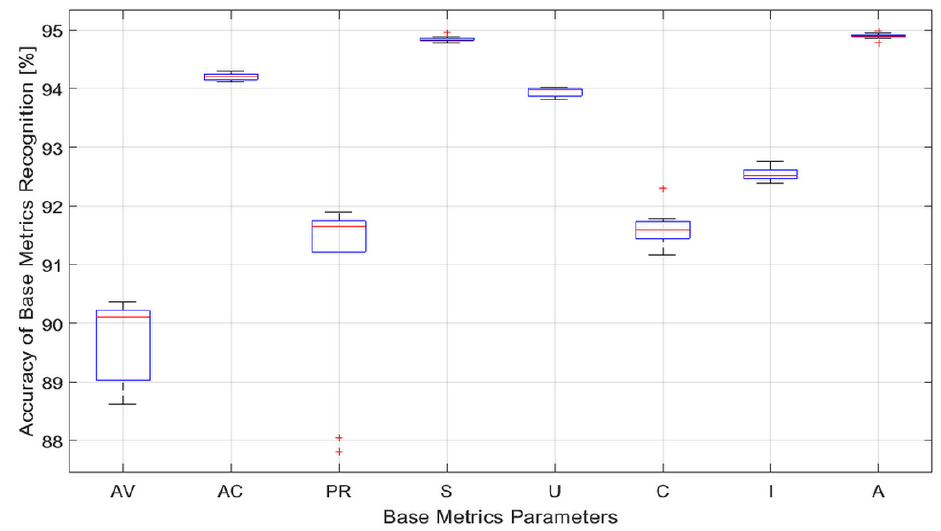
Figure 2. The classification statistics of CVSS 3.x vector parameters using the parameters from Table